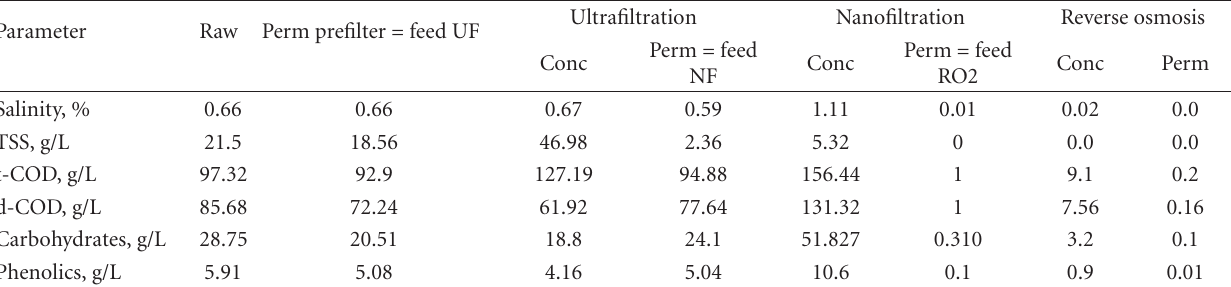
Table 1: Physicochemical characterization of fractions of the various treatment stages.